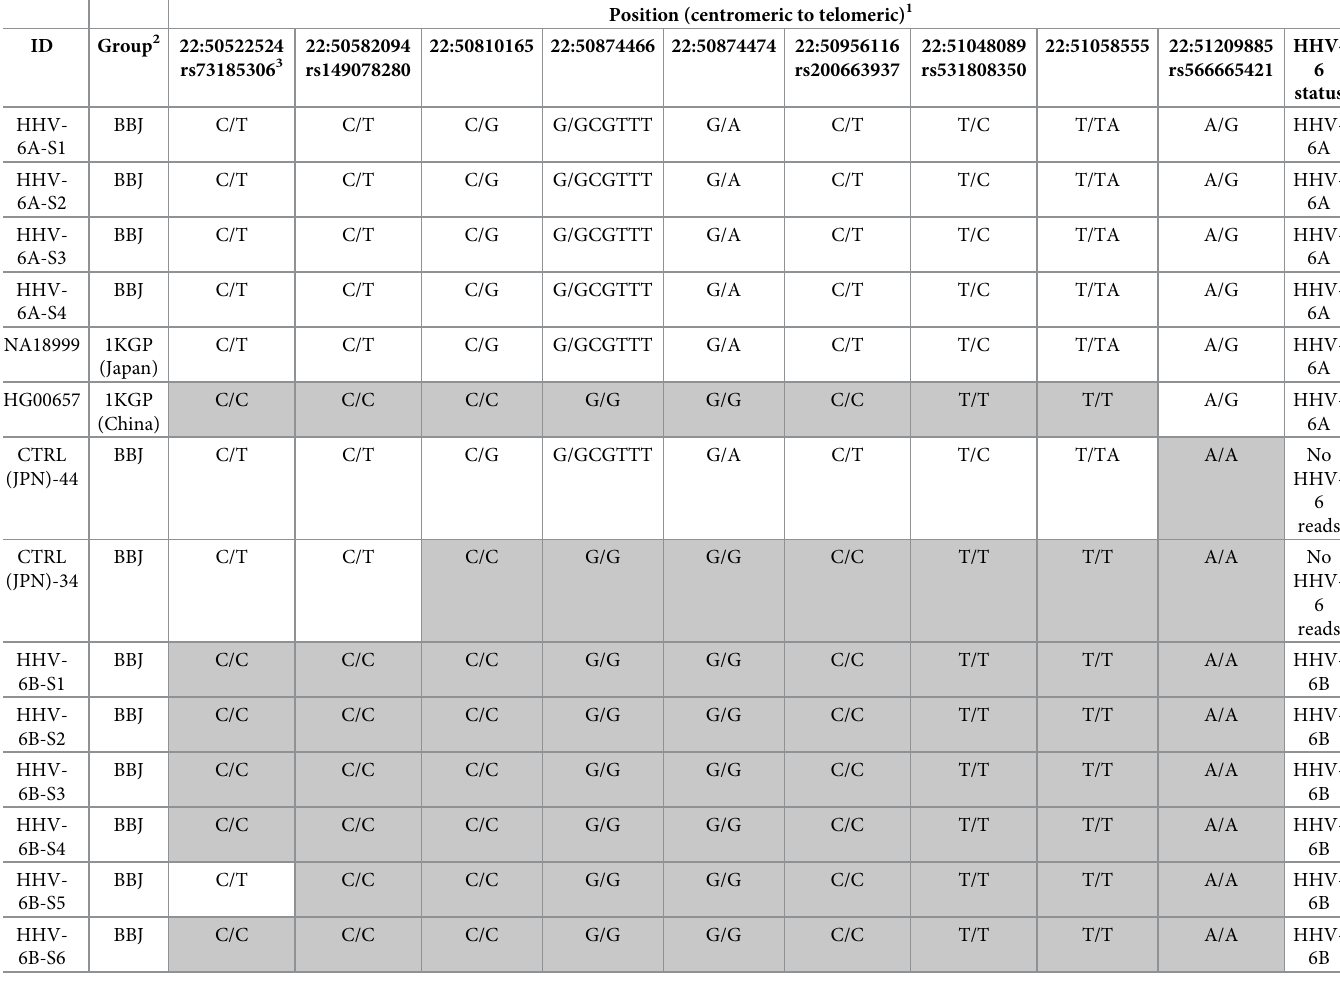
Table 1. Rare variants in chromosome 22q subtelomeric region co-segregate with integrated HHV-6A.